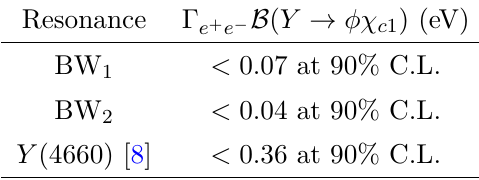
Table 5 . The upper limit of Γ B ( Y → φχ c 1 ) at 90% C.L. for the possible structures in φχ c 2 , e + e − where BW 1 and BW 2 correspond to eqs. (3.5) and (3.6),